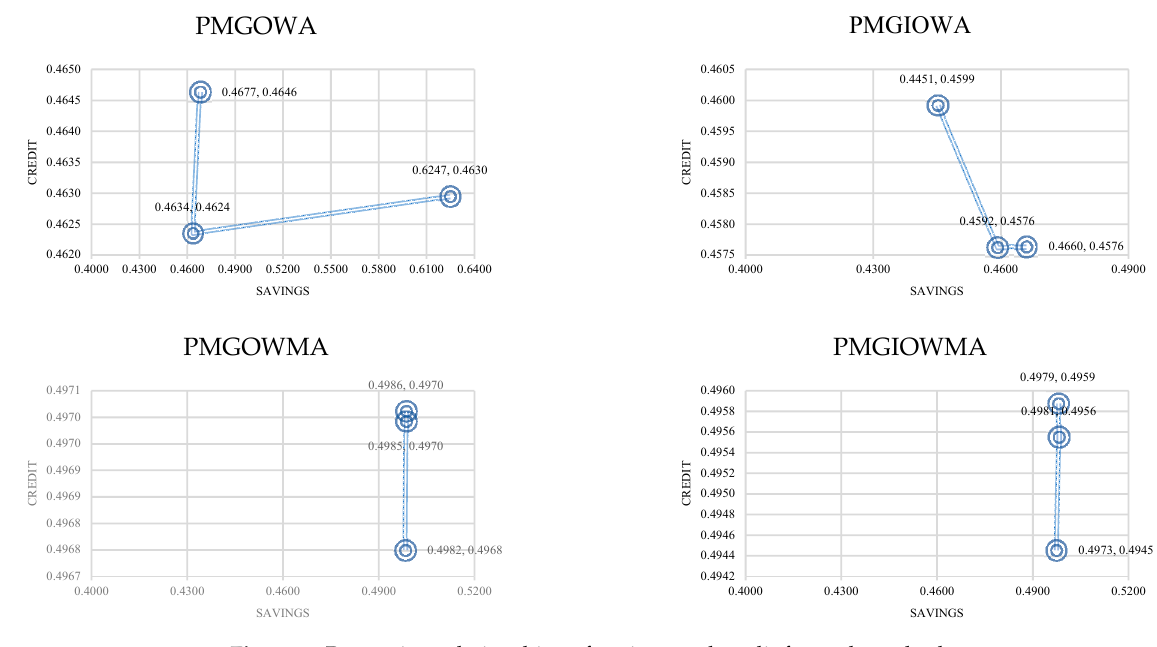
With the results obtained, it is possible to graph and observe the change in perceptions about credit and savings. Figure 1 shows the relationship between perceptions for each method. Figure 2 shows the perceptions for each group regarding credit and savings for each method used. Figure 3 shows the perceptions grouped into savings and credit.